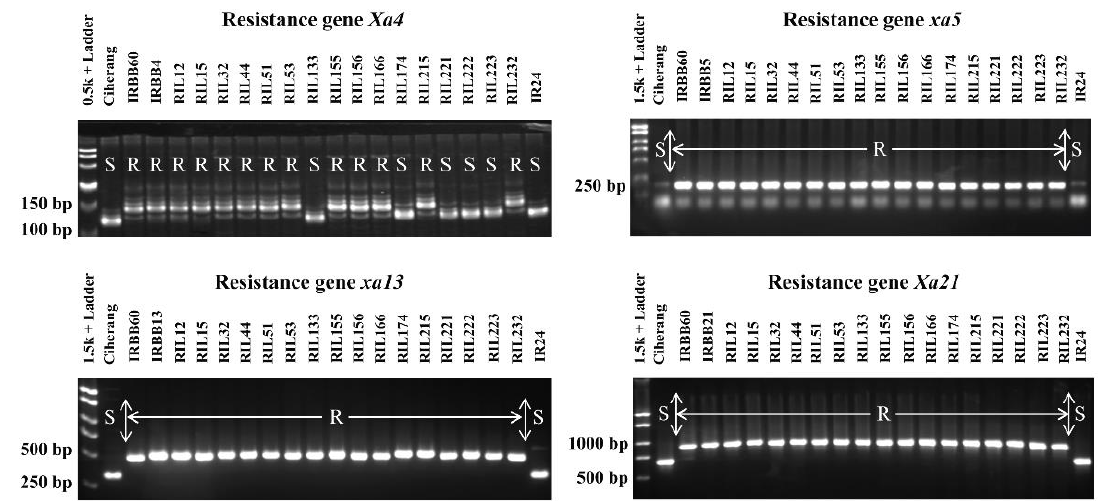
Figure 4. Molecular markers analysis of selected RILs along with their parent lines and resistant and susceptible checks, showing the homozygous condition of the BB resistance genes Xa4 , xa5 , xa13 , and Xa21 . R = resistant; S = susceptible.